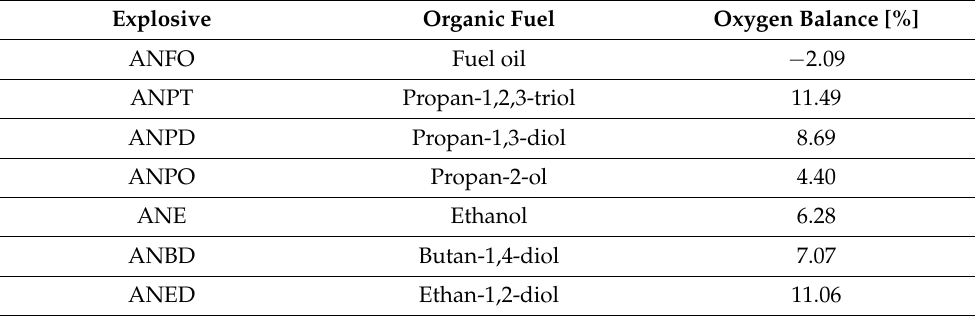
Table 3. Oxygen balance of ammonium nitrate mixtures with organic fuels 94/6 (by mass).